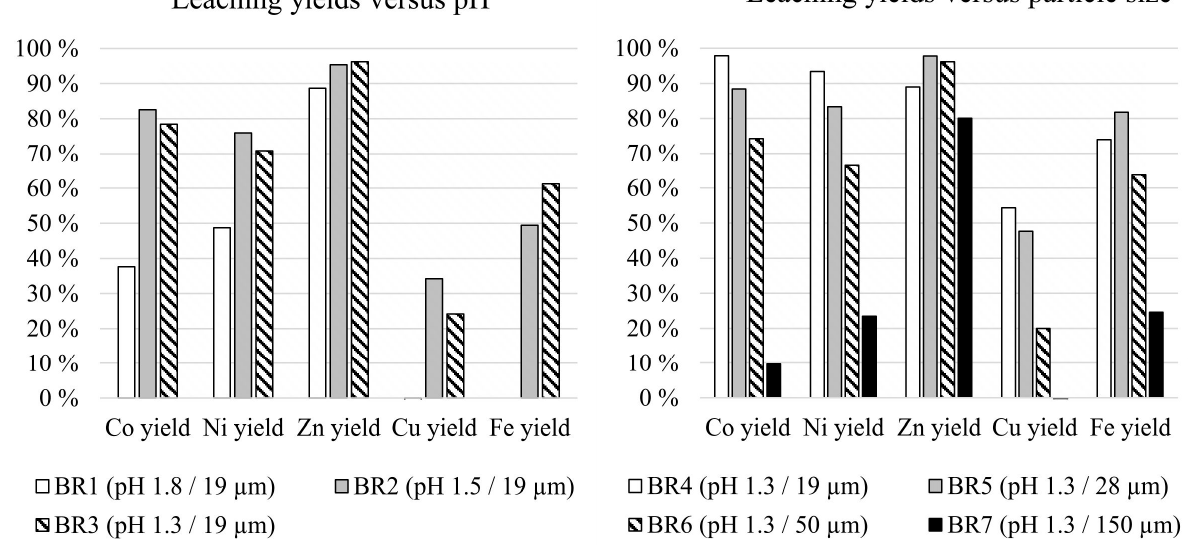
Figure 4. Leaching yields according to the mass balance calculations after 7 days.